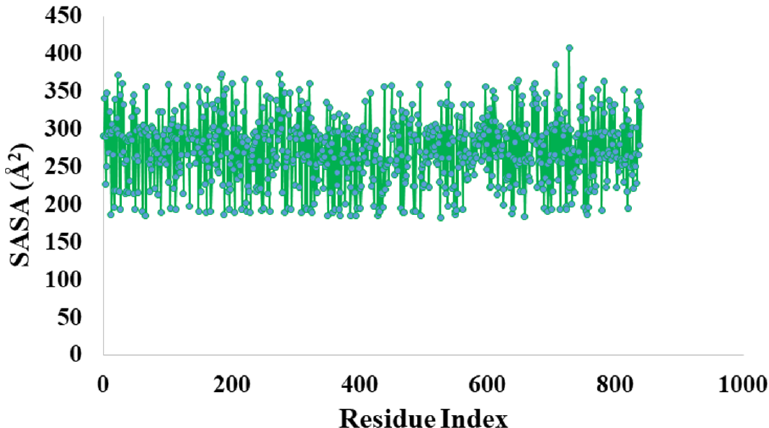
Figure 10. Solvent Accessible Surface Area [SASA] graph of Urease- 4i complex.